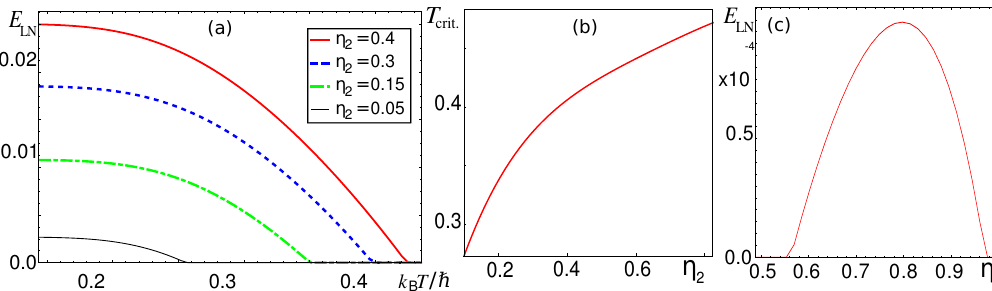
Figure 3: Coupling strength dependence of the entanglement between the two kinds of trapped impurities . (a) Entanglement as a function of T for various couplings. As shown, for the values of η second type of impurities, η entanglement decreases and eventually vanishes at certain T the entanglement goes to zero increases with η the entanglement at fixed T = 4.35 nK increases for a range of η to zero. In this case we considered n of the graphs, we are considering impurities of potassium K in a bath of particles of Rubidium Rb. The parameters used in these plots are: Ω